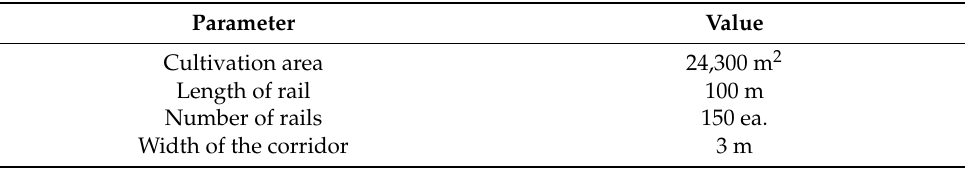
Figure 1. The greenhouse environment. ( a ) corridor; ( b ) corridor with machines; ( c ) rails; ( d ) top view of smartfarm. Table 1. Specification of the greenhouse.